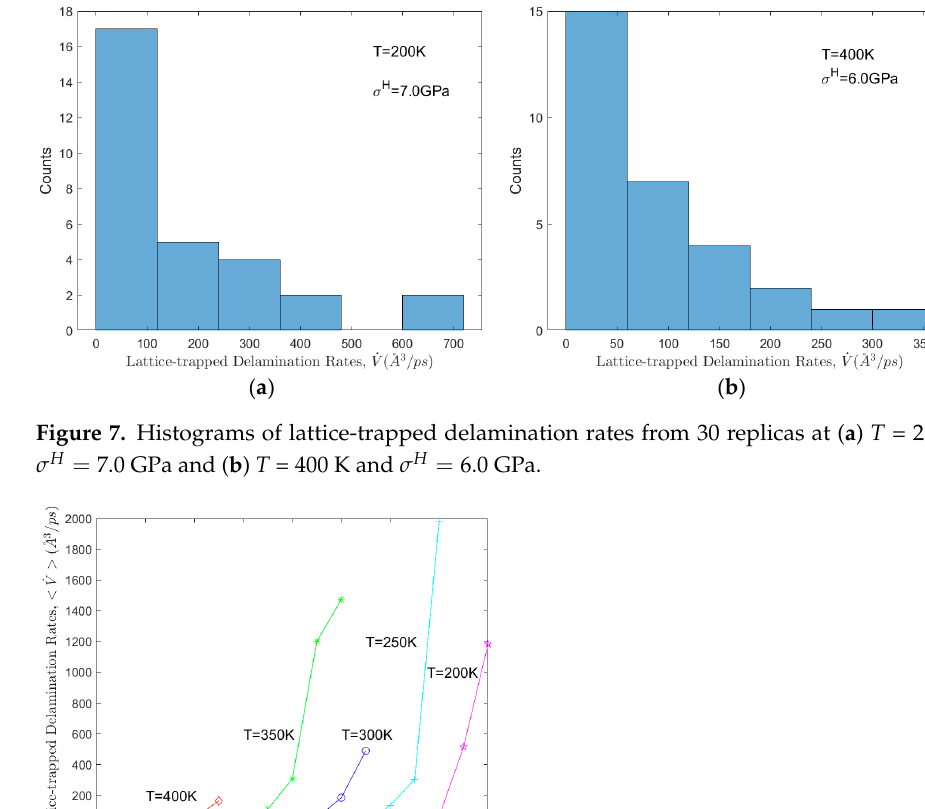
Figure 6. Crack volume as a function of time for simulations with T = 400 K and 𝜎 𝐻 = 6.0 GPa, each with a different random seed for atomic velocity initialization. Dashed lines denote the lattice-trapped delamination rates and circles mark the appearance of a dislocation.